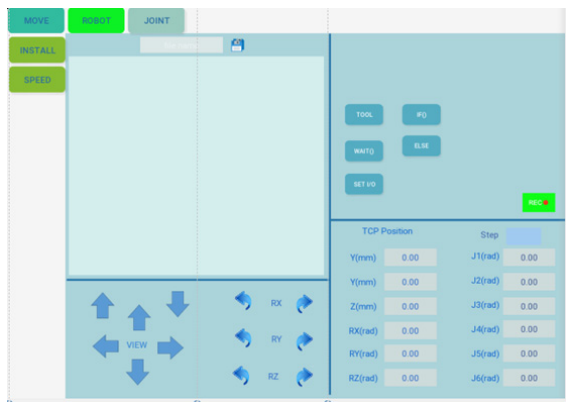
Figure 8. Teach pendant interface